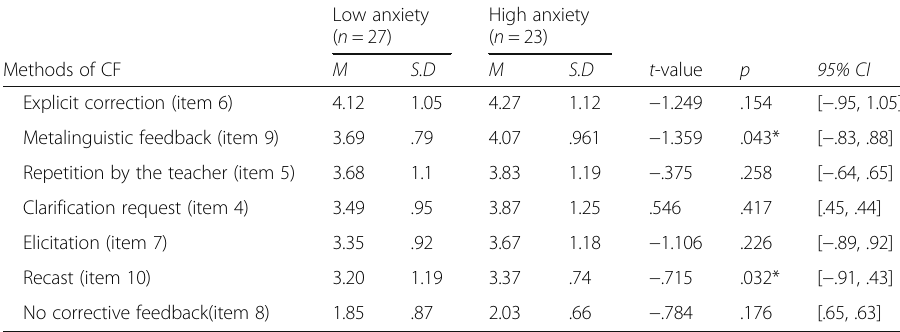
Low anxiety High anxiety ( n = 27) ( n = 23)